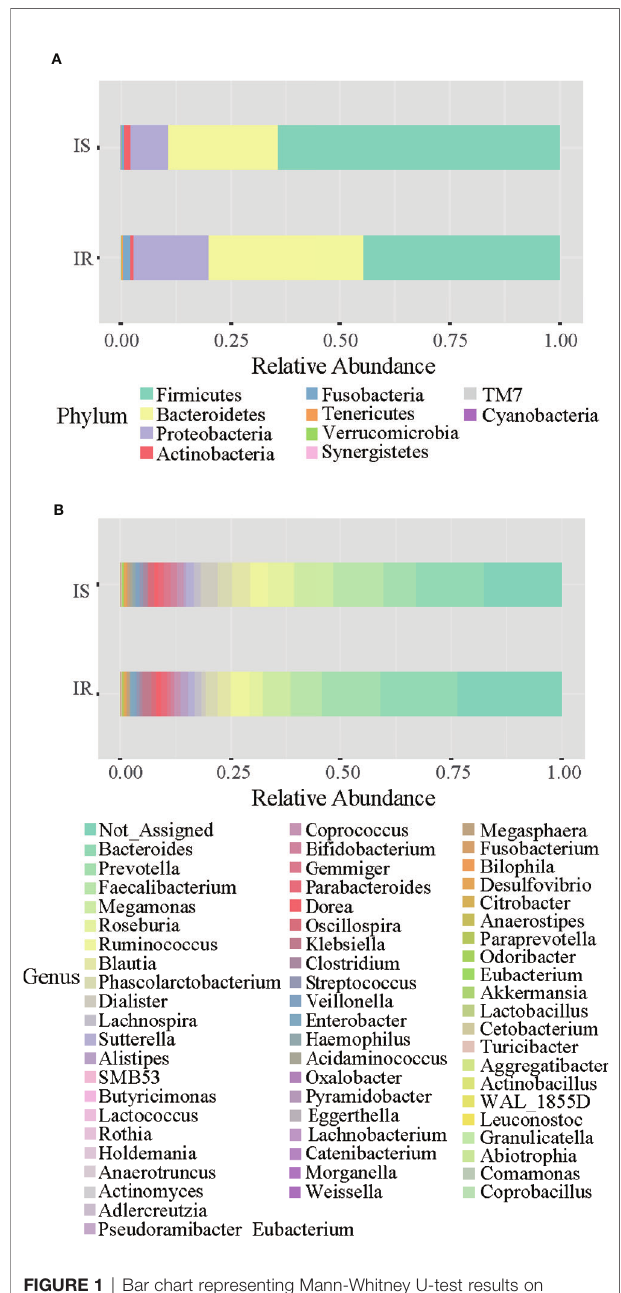
FIGURE 1 | Bar chart representing Mann-Whitney U-test results on operational taxonomic units (OTUs) grouped in phyla (A) and in genus (B) of the IR and IS groups. Each column in the plot represents a group, and each color in the column represents the percentage of relative abundance for each